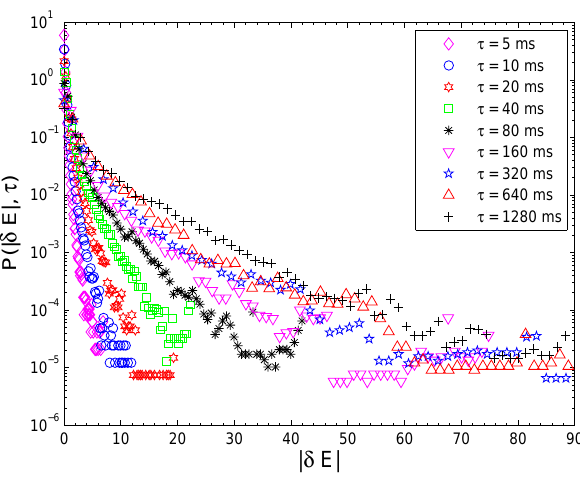
Fig. 2. P( | δE | ,τ) at nine different time scales varying from τ = 5 to 1280ms. The unit of | δE | is mVm − 1 .